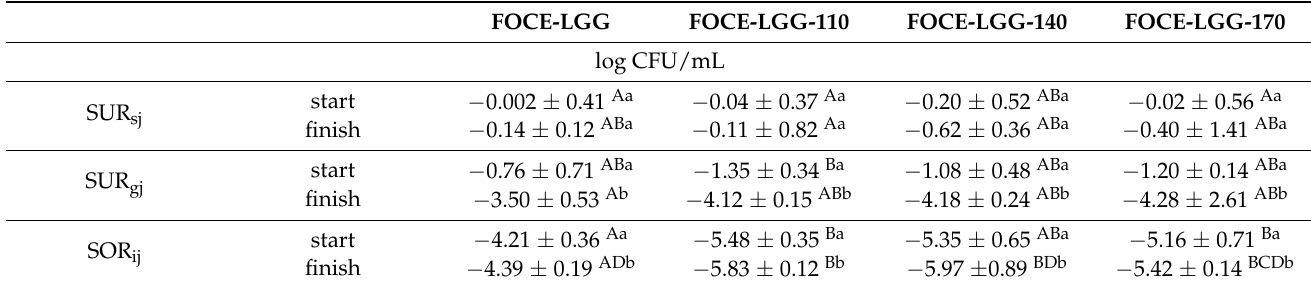
Table 4. LGG survivability (decrease of viable counts) in saliva juice, gastric juice and intestinal juice.